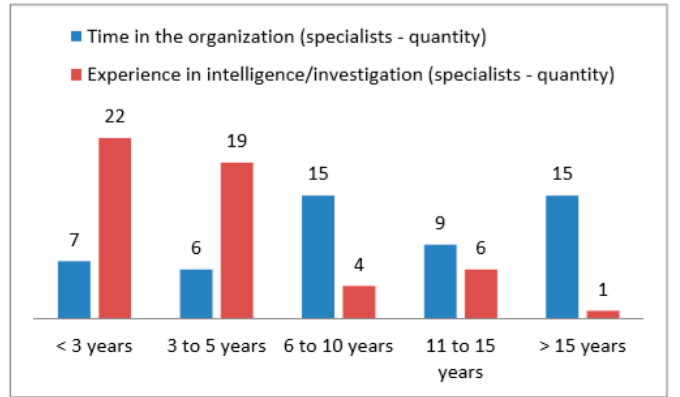
Figure 13. Quantitative distribution of specialists by time (in years) in the organization and experience in carrying out or supporting intelligence and investigation activities.